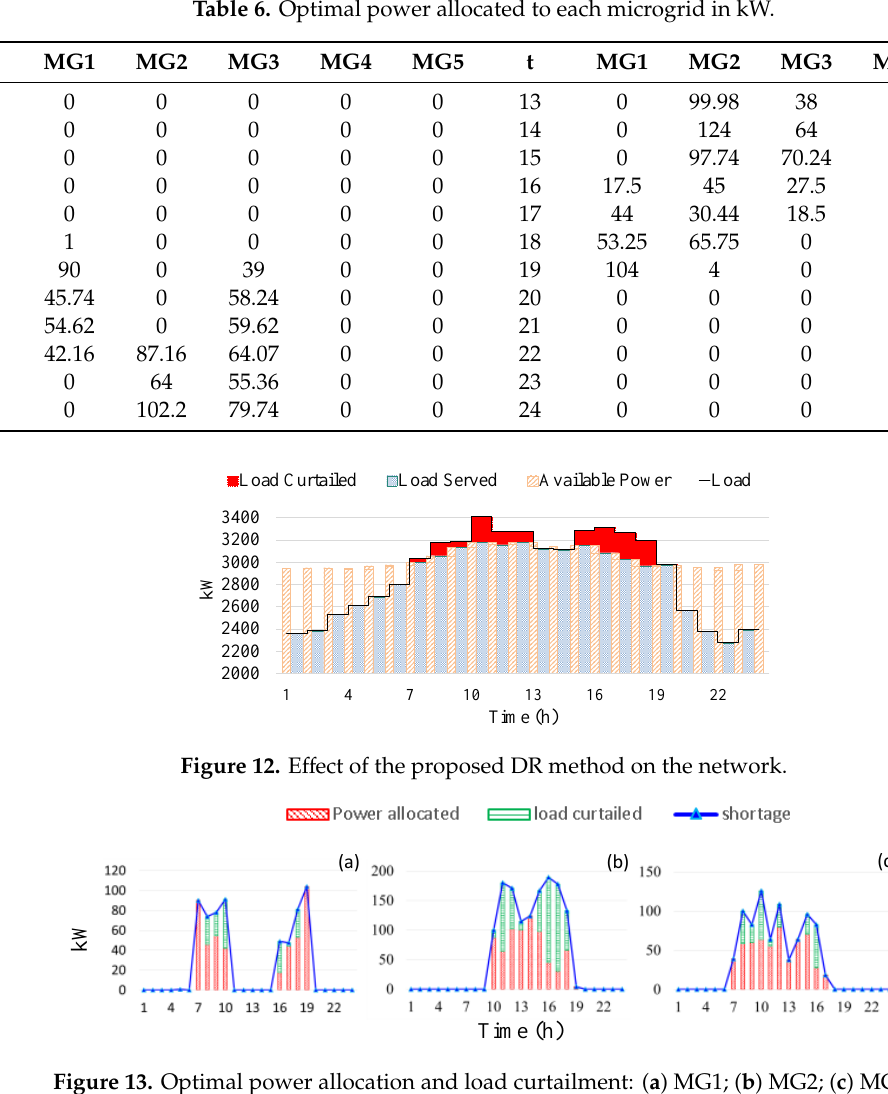
Figure 13. Optimal power allocation and load curtailment: ( a ) MG1; ( b ) MG2; ( c ) MG3.